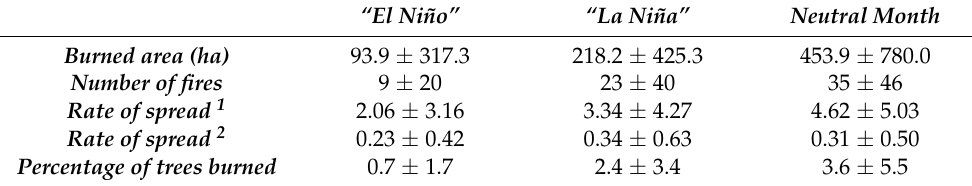
Table A3. Average fire regime parameters under the ENSO